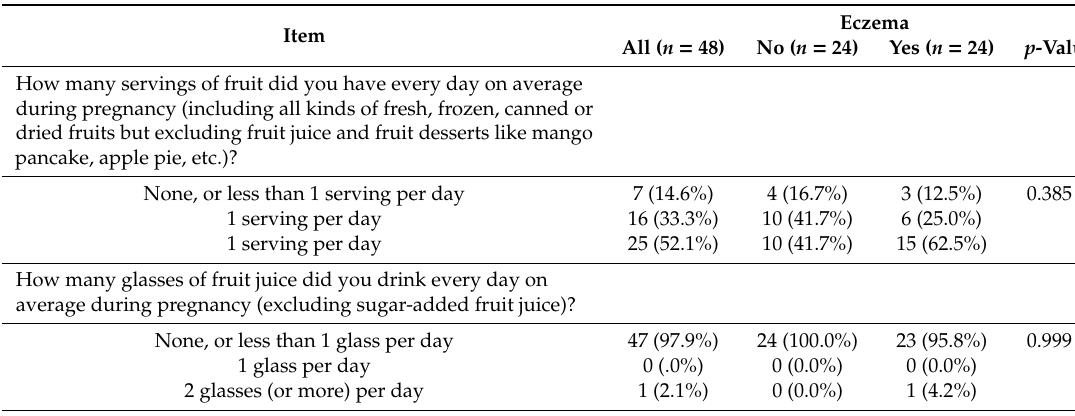
Table 3. Dietary pattern in 48